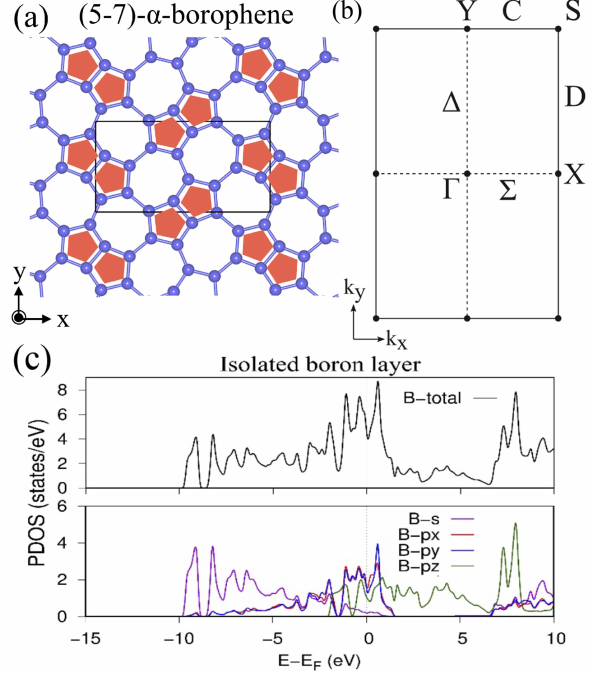
Figure 5. (5–7)- α -borophene. ( a ) Lattice structure of (5–7)- α -borophene. ( b ) BZ of the (5–7)- α - borophene. ( c ) Total and partial density of state of (5–7)- α -borophene obtained by the first-principles calculation (adapted from [38,41]).